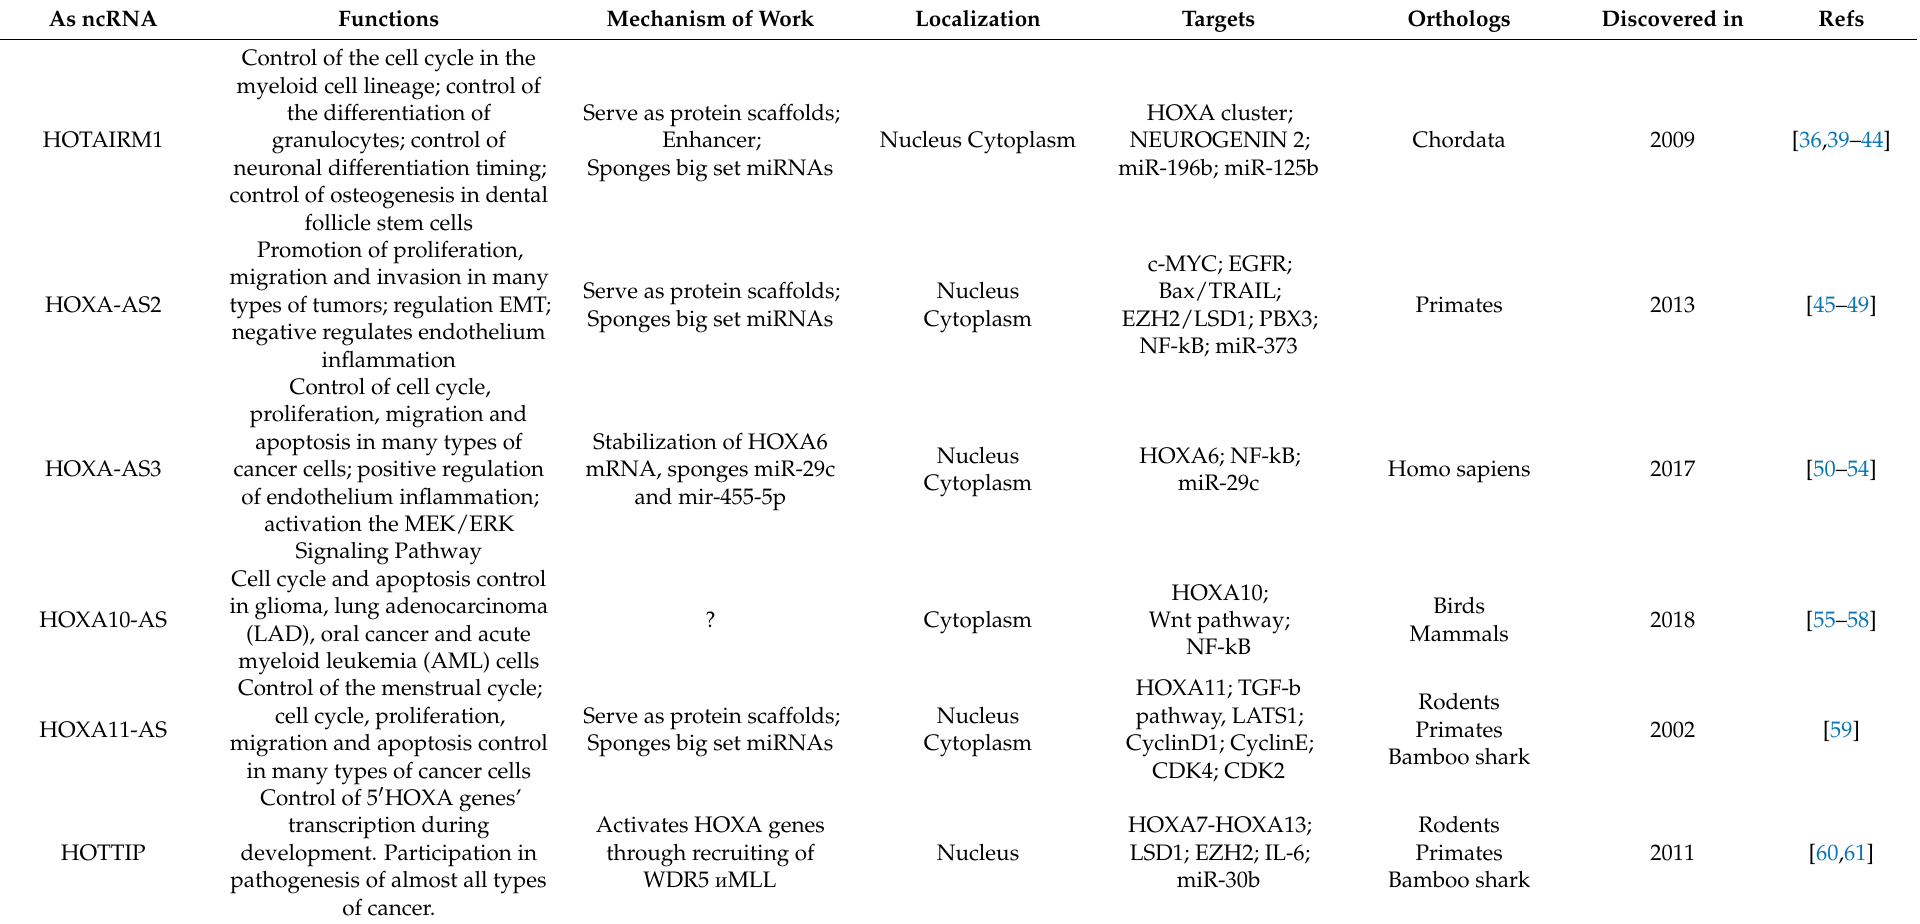
Table 2. Antisense lncRNAs from four human Hox clusters and their main functions and